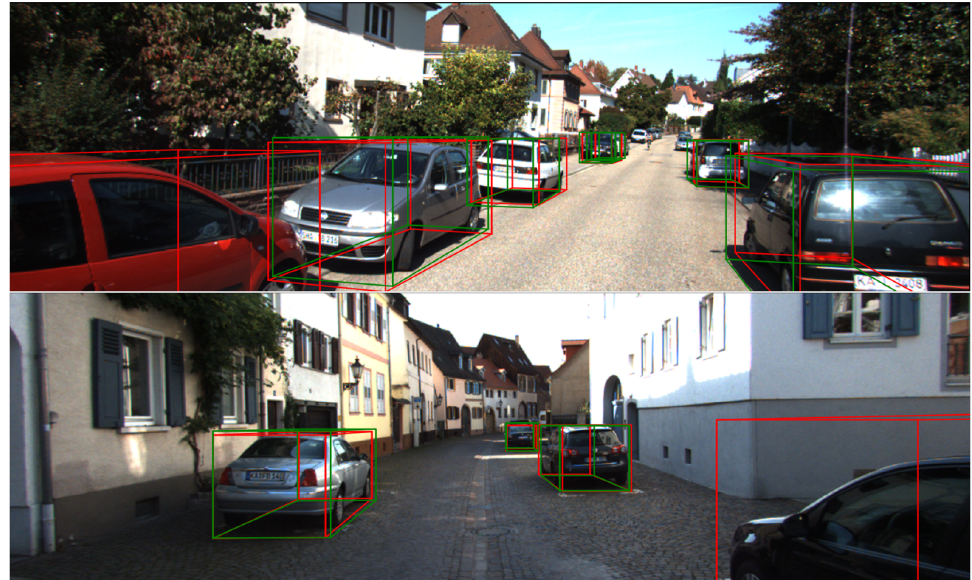
Figure 17. Some failure cases of our method. We use red box to denote the ground truth box, green box to denote the predicted